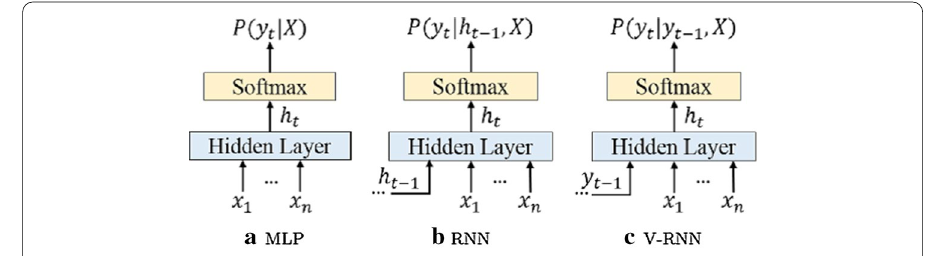
Fig. 3 V-RNN model versus the MLP and the standard RNN [3]